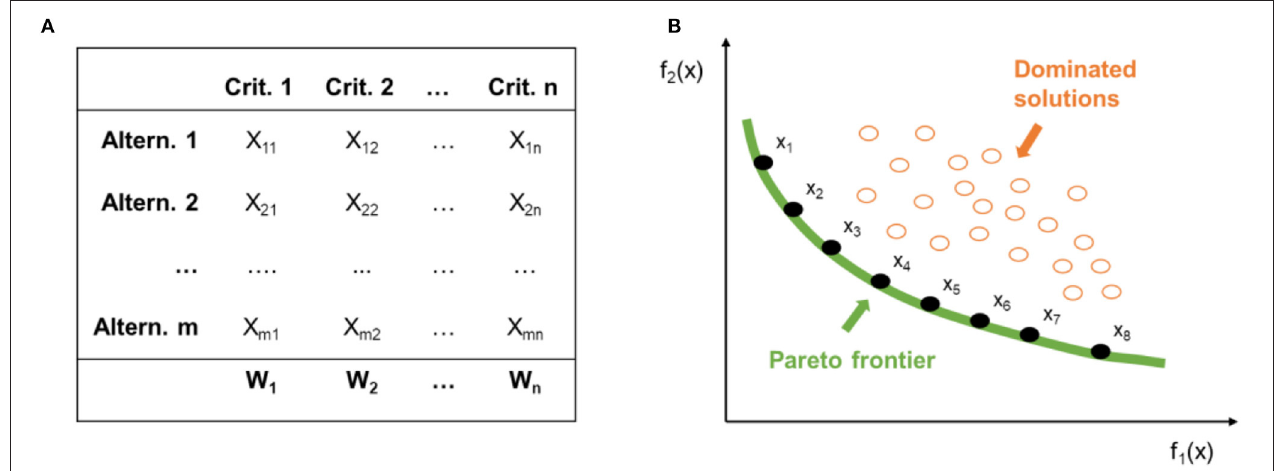
FIGURE 9 | (A) Common structure of a MADM; (B) two-objective MODM, showing Pareto frontier and dominated